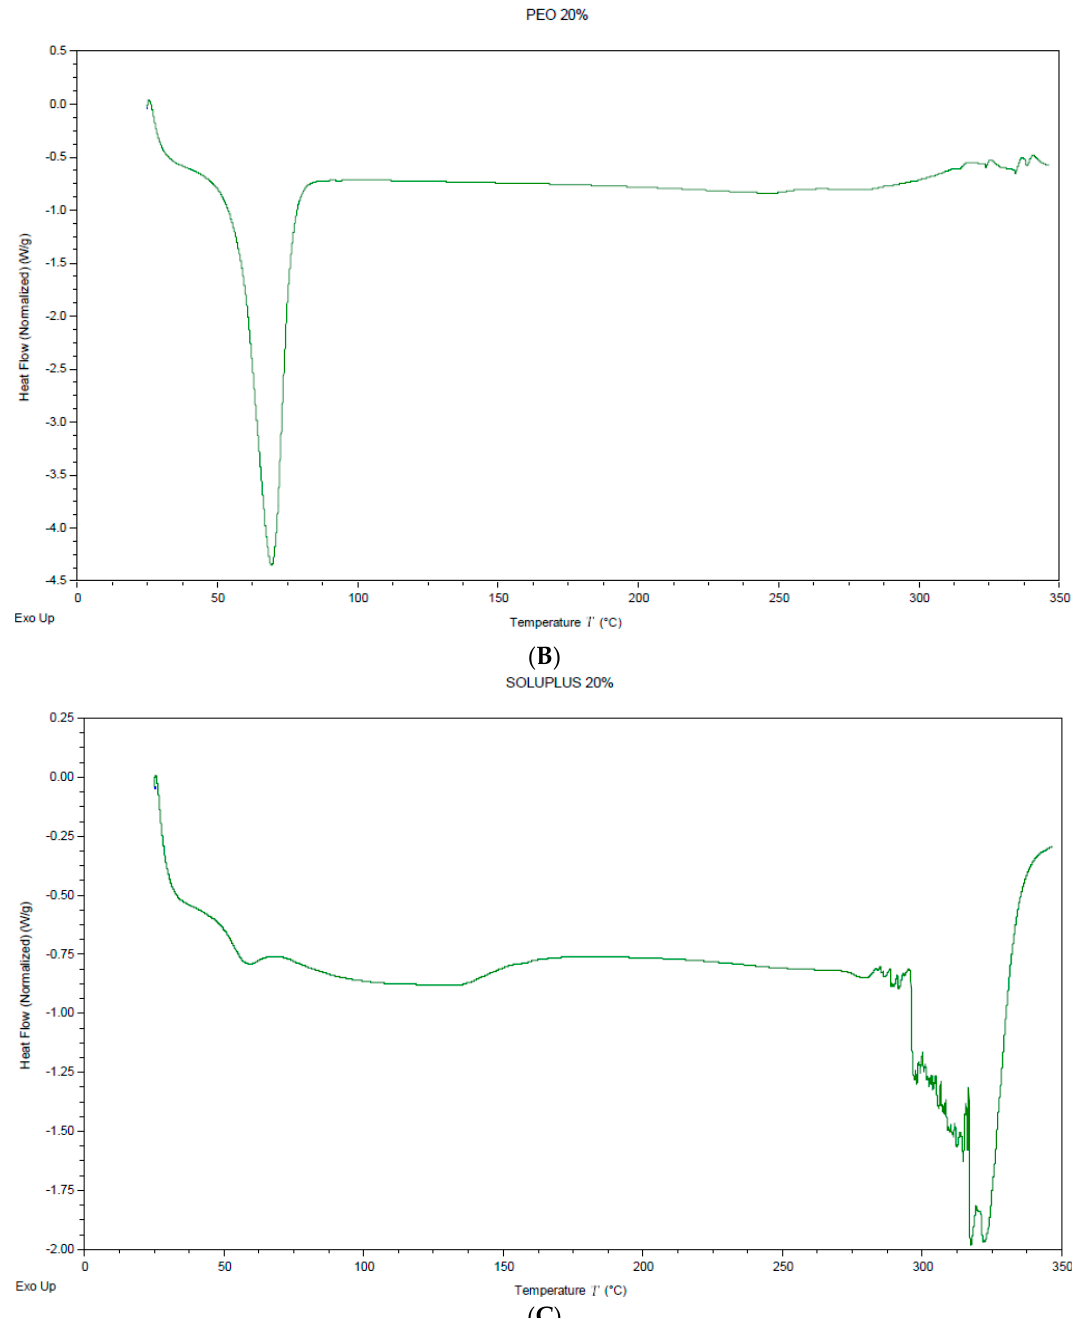
Figure 1. Differential Scanning Calorimetry (DSC) thermograms of pure drug ( A ), PEO film ( B ), and Soluplus® film ( C ).